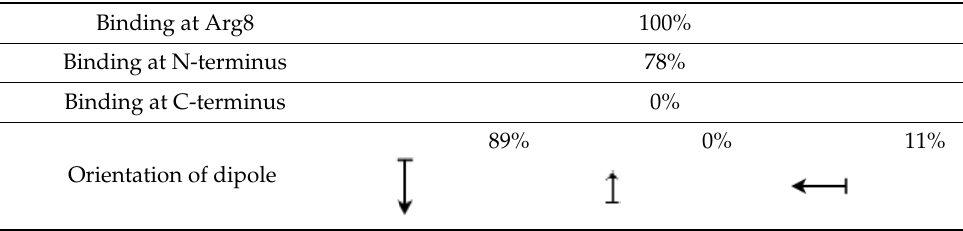
Table 4. GnRH-I dipole moments at various stages of adsorption: 0 = starting position; D1/D2 = diffusion moments in solution pre-adsorption; AD = at time of adsorption; 10 / 20 = 10 / 20 ns post- adsorption. The arrows signify the direction of the dipole moment vector, with dashes (horizontal lines) representing vectors parallel to the silica surface facing away from the point of view, and circles representing vectors parallel to the silica surface facing towards the point of view. The numbers show the magnitude of the dipole moments measured in D. The x-axis runs across the page, the y-axis runs normal to the page, and the z-axis runs up the page. Table 5. Summary of GnRH-I adsorption configurations. Dipole arrows indicate their orientation, with the down facing arrow showing dipoles facing the silica surface, the upright facing arrow showing dipoles facing away from the silica surface and the horizontal arrow shows dipoles hori- zontal to the silica surface. Peptide